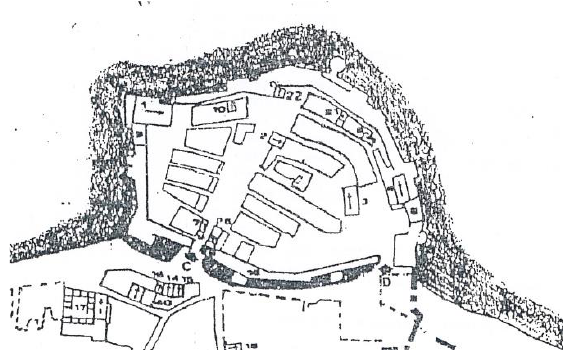
Figure 2. Development of historic district during the Angioin period. Source: Retrofit Plan of historic district (1994).